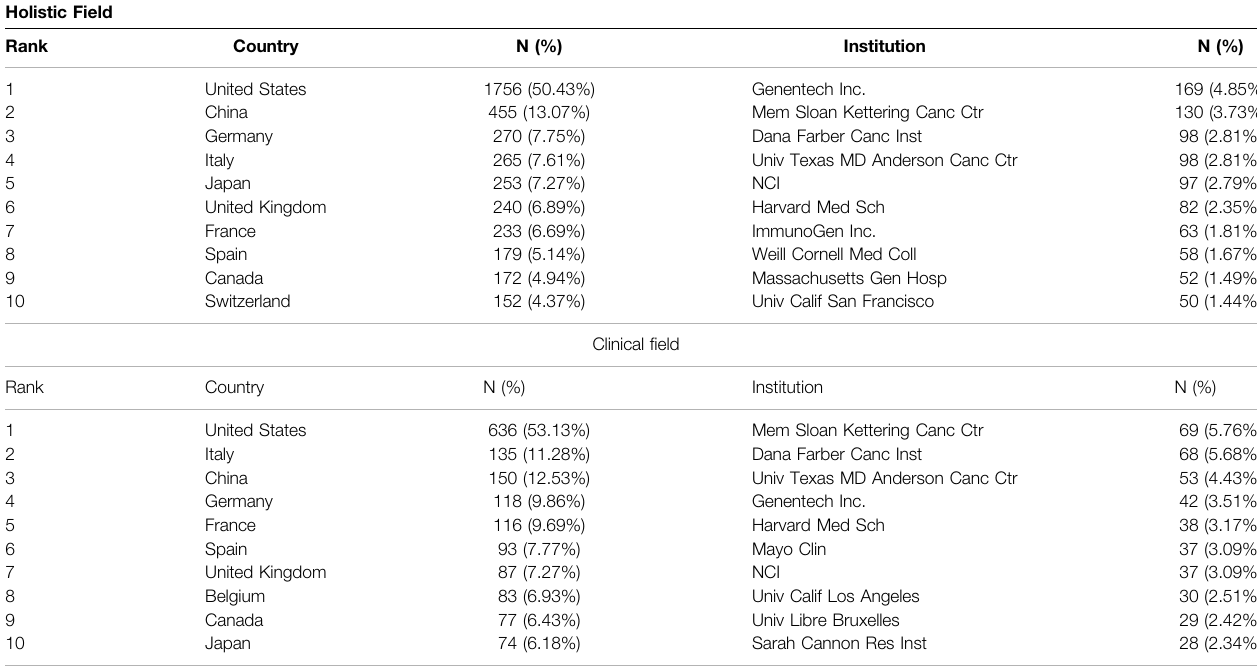
TABLE 1 | The top 10 countries and institutions contributing to publications of ADC research in the solid cancer fi eld [n (%)]. Holistic